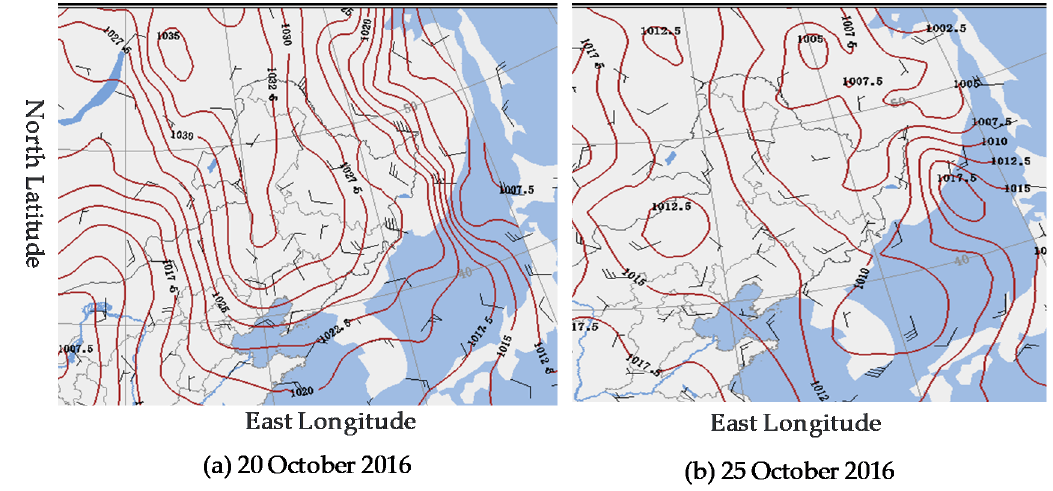
Figure 1. Sea level pressure at 11:00 (hereafter Beijing time). ( a ) 20 October 2016; ( b ) 25 October 2016